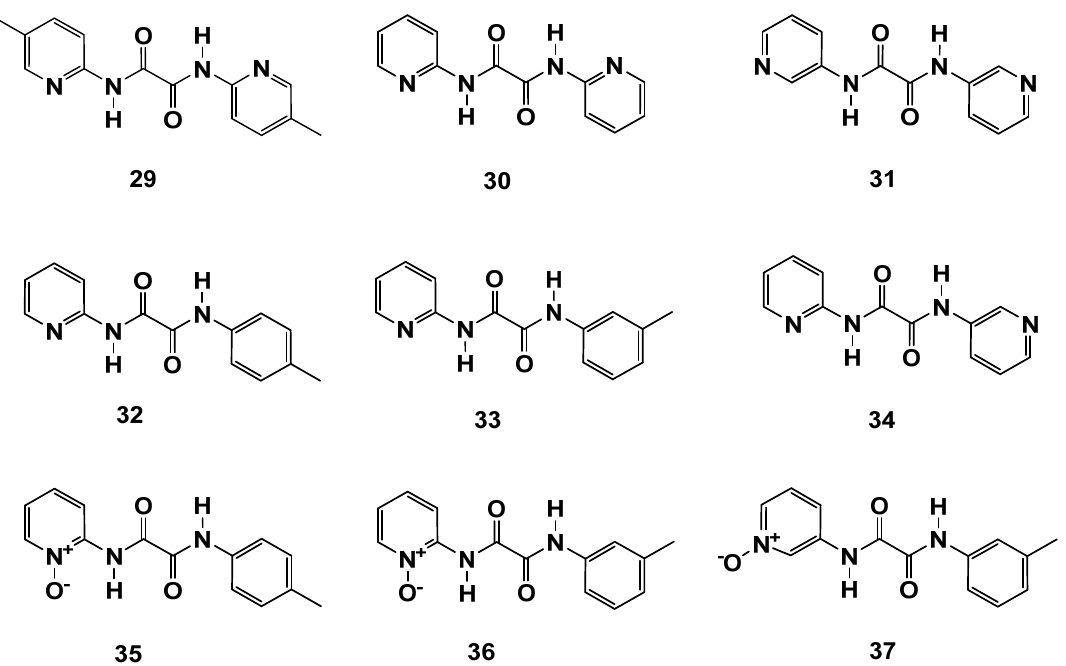
Figure 12. N , N’ -diaryl-oxalamic acid diamides with C2 symmetry and broken symmetry. Table 9. C 2 -symmetric N 1 , N 2 -bis(pyridin-2-yl or -3-yl) oxalamides ( 29–31 ). N 1 ,N 2 - diaryl